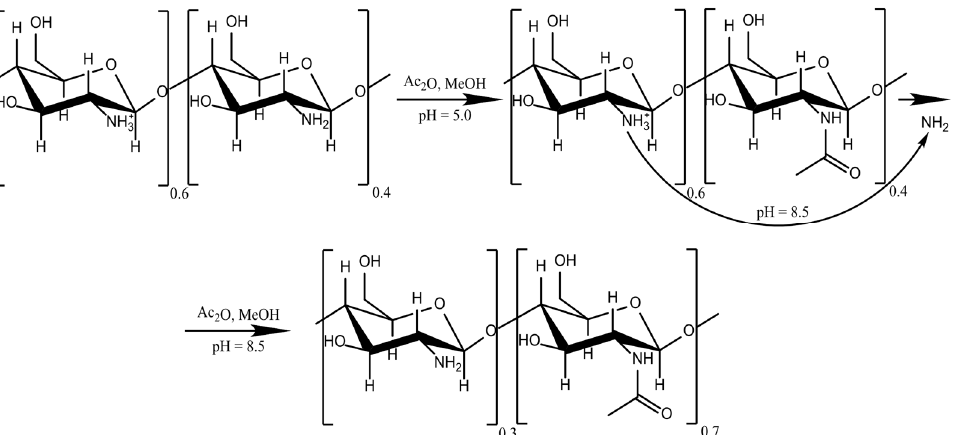
Figure 6. Scheme of a two-step chitosan acetylation reaction.